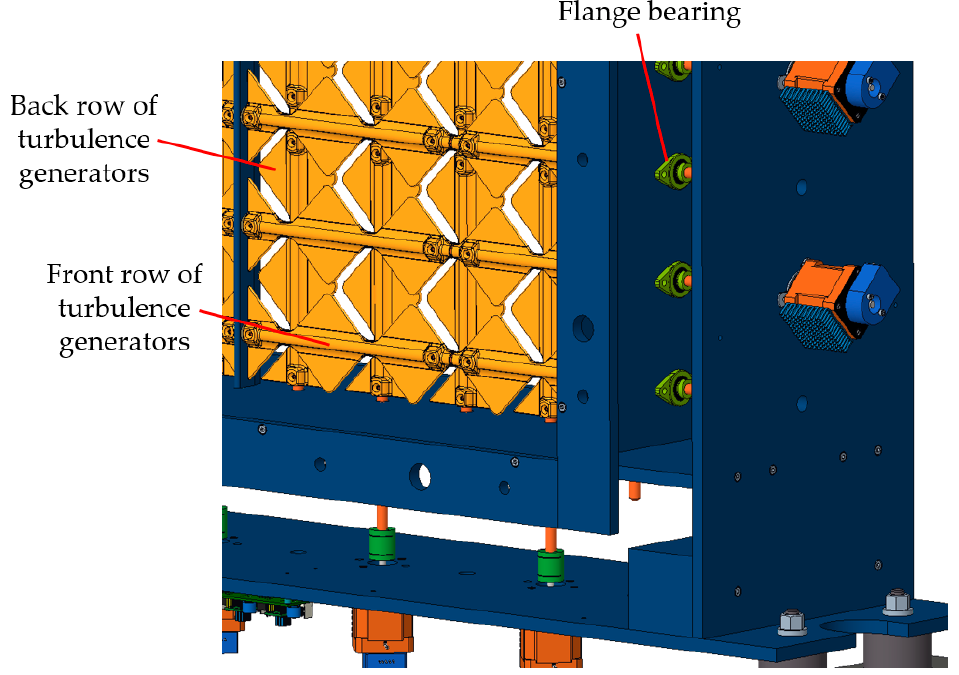
Figure 5. Partial view of the active turbulence grid, in which the distance between the two rows of turbulence generators can be seen.